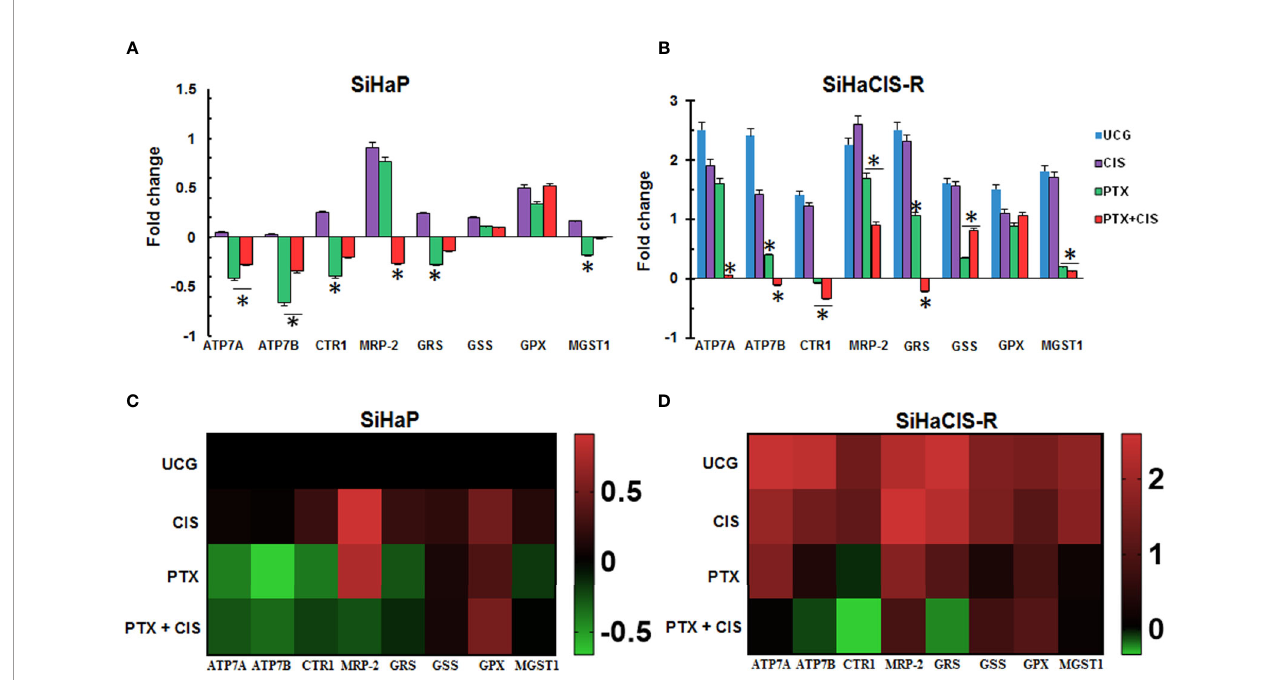
FIGURE 6 | PTX downregulated ef fl ux pump, multidrug resistance, and glutathione genes in SiHaP and SiHaCIS-R cells (A, B) . SiHaP and SiHaCIS-R cells were treated with CIS (30 m M), PTX (4 mM), or PTX + CIS (4 mM + 30 m M) for 4 h. Ef fl ux (ATP7A , ATP7B , and MRP-2) , in fl ux ( CTR1) , and Glutathione genes ( GRS , GSS , GPX , and MGST1) were evaluated by qPCR. RPL32 was used as a reference gene. * p < 0.05 = statistical signi fi cance, comparisons were performed between PTX or PTX + CIS vs. CIS or UCG groups. Data are expressed as fold changes relative to the UCG of SiHaP cells (C, D) . Heat Maps of ef fl ux (ATP7A , ATP7B , and MRP-2 ), in fl ux ( CTR1 ), and glutathione genes (GRS , GSS , GPX , and MGST1 ) expressed in SiHaP and SiHaCIS-R cells treated with PTX, CIS, or PTX +